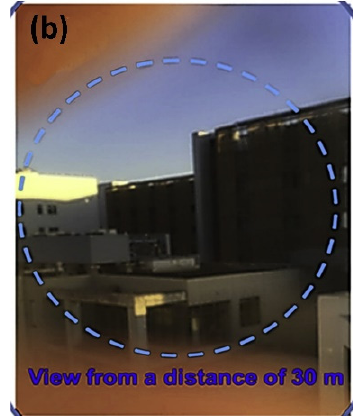
Figure 15. Comparison of transparent armor materials for STANAG 4569; ( a ) Level 2 and ( b ) Level 3 [65]. Reprinted with permission from Ref. [65]. Copyright 2017, copyright ELSEVIER.